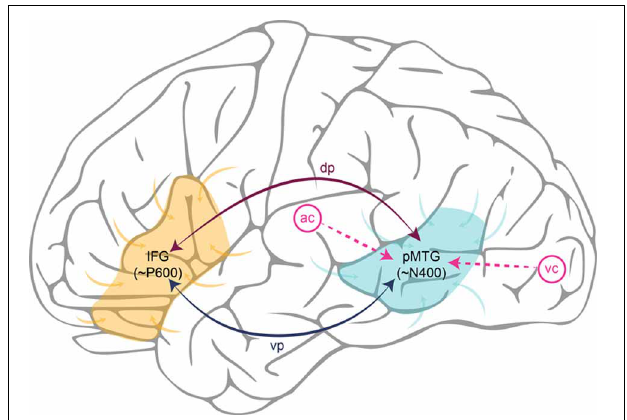
FIGURE 1 | Schematic illustration of a Retrieval-Integration cycle in the left hemisphere. Words reach the posterior Middle Temporal Gyrus (pMTG) via the auditory cortex (ac) or the visual cortex (vc), depending on whether the linguistic input is spoken or written. The pMTG retrieves the lexical information associated with a word from the association cortices (generating the N400). The retrieved information is then connected to the Inferior Frontal Gyrus (IFG) via one of the white matter tracts in either the dorsal pathway (dp) or the ventral pathway (vp). The IFG integrates this information with a representation of the prior context into an updated representation of what is being communicated (generating the P600). Finally, the representation constructed in the IFG feeds back to the pMTG via white matter tracts in the dorsal or ventral pathway, causing pre-activation of lexical features of possible upcoming